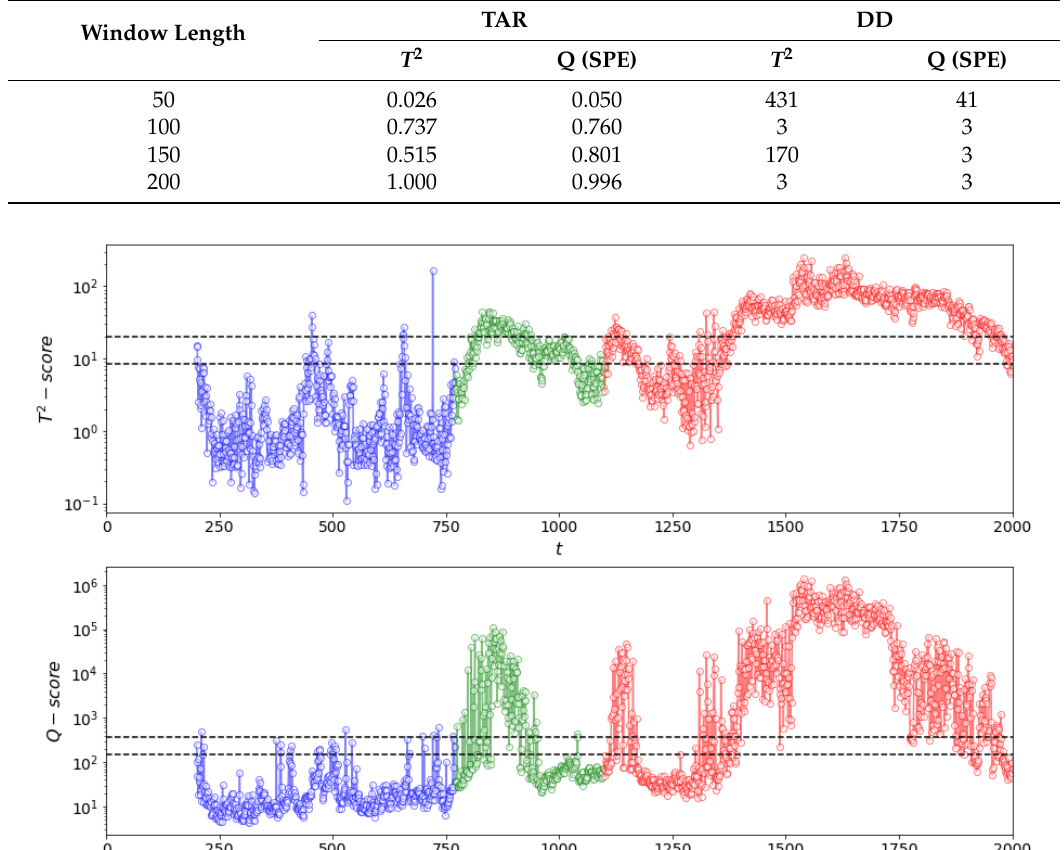
Table 8. Monitoring results on AG mill power draw using Method III with embedding dimension of four.